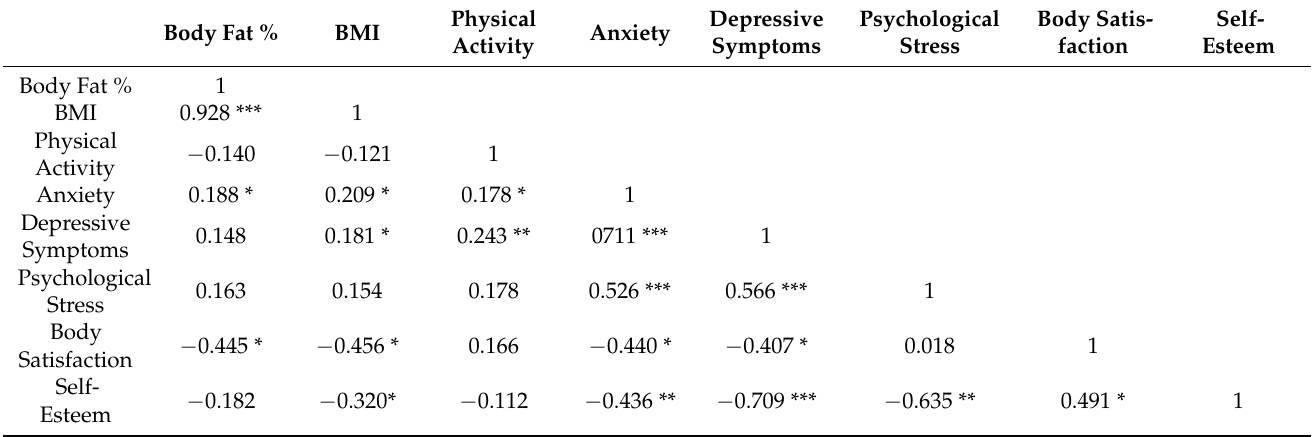
Table 5. Pearson correlations between body composition, physical activity, mental health, body satisfaction, and self-esteem for